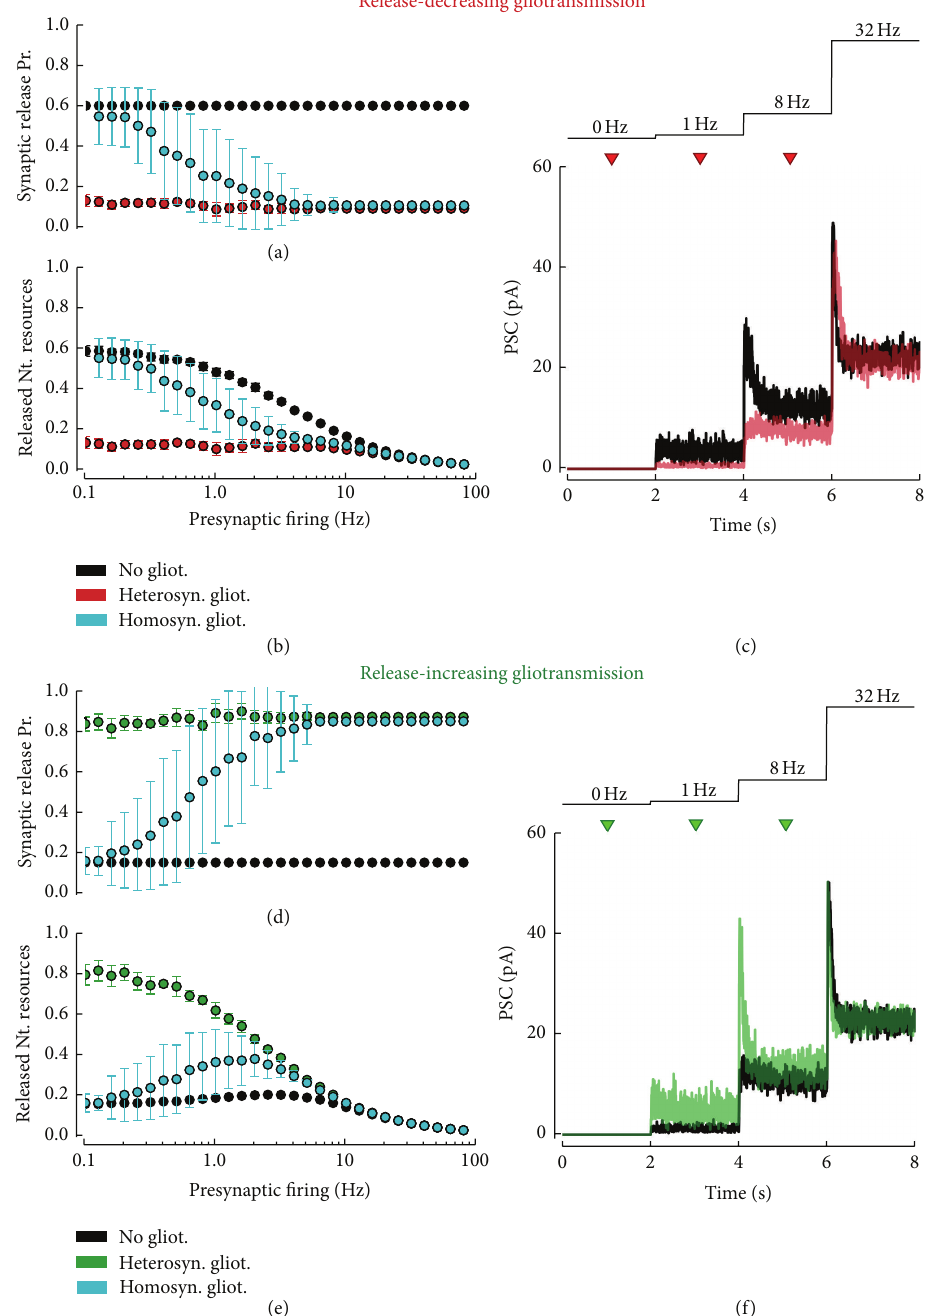
Figure 4: Gliotransmitter-mediated modulation of synaptic frequency response. Decrease (a) or increase (d) of synaptic release